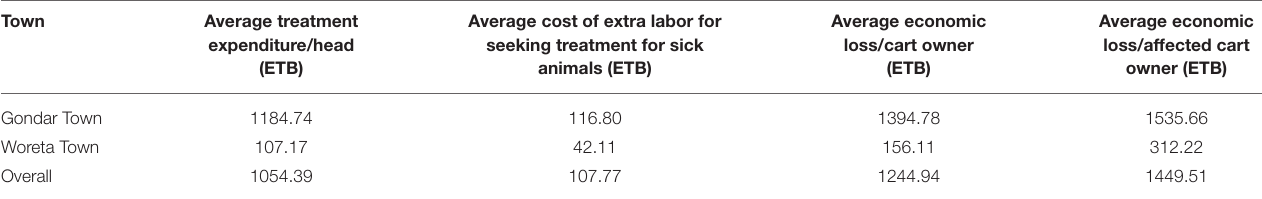
TABLE 3 | Annual economic loss due to treatment costs per cart owner and per affected cart owner by